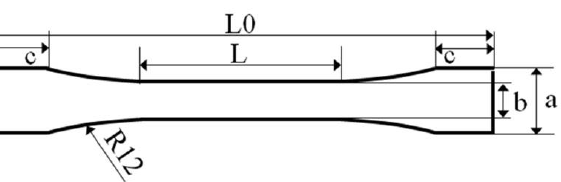
Figure 3. Ultimate tensile test specimen. (mm) a: 4.0 ± 0.1, b: 2.0 ± 0.1, c: 3.5 ± 0.1, thickness: 2.0 ± 0.2, L: length of reduced section 12.0 ± 0.2, L0: overall length 30.0 ± 0.2